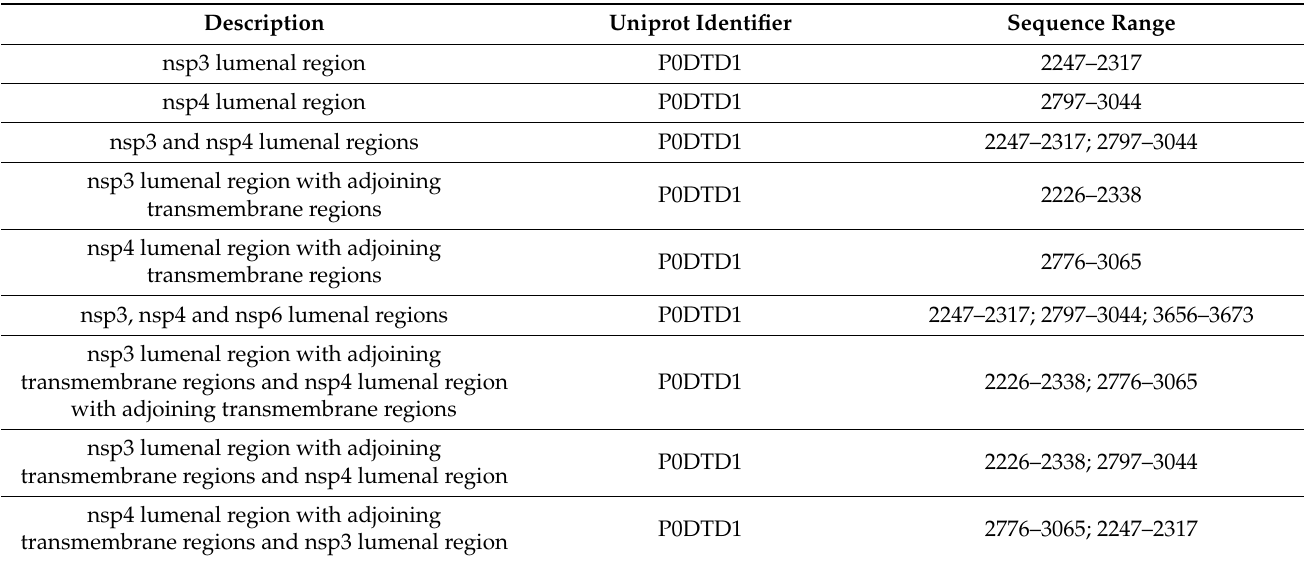
Table 5. Overview of the input sequences used for protein structure prediction with